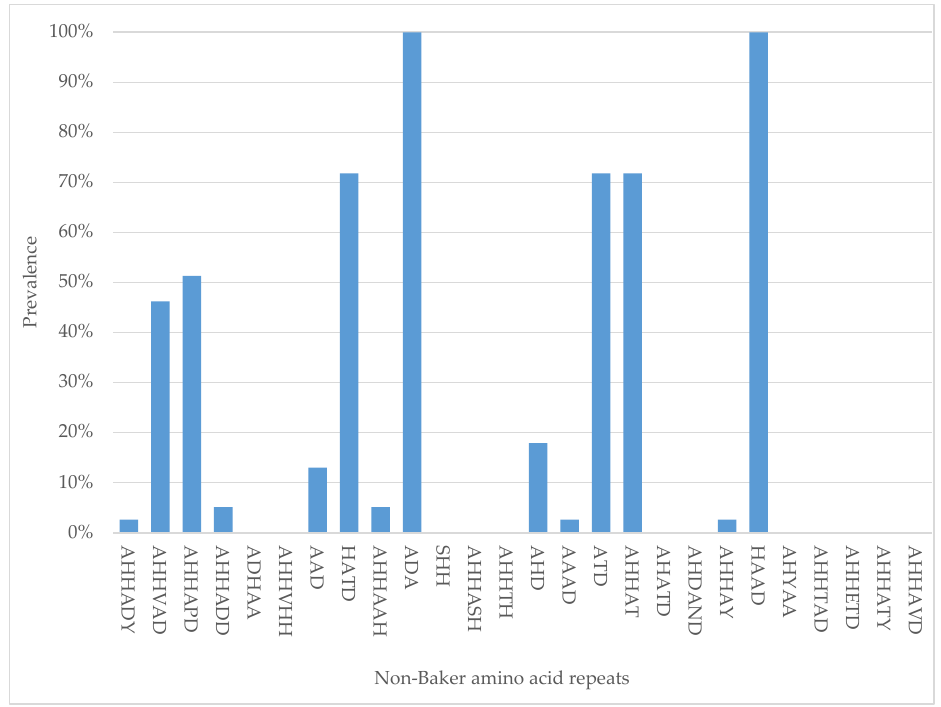
Figure 2. Frequency of “non-Baker” amino acid repeat types in 39 Tanzanian P. falciparum isolates.